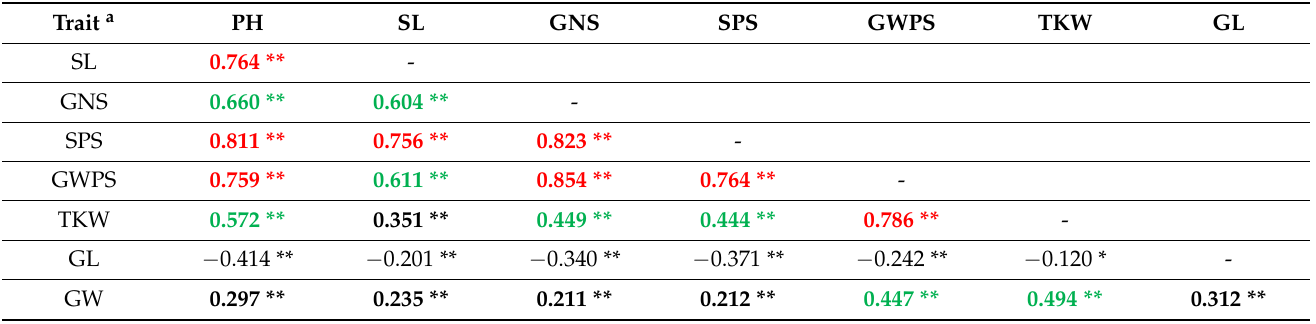
Table 1. Correlation coefficients between plant height and yield component traits.